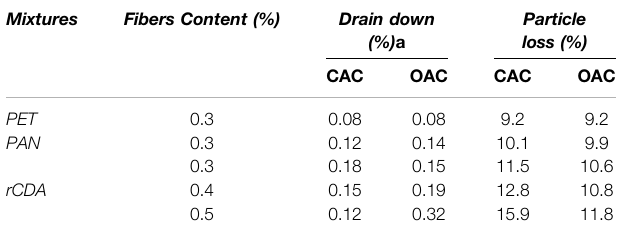
TABLE 4 | Results of drain down and Cantabro particle loss tests.